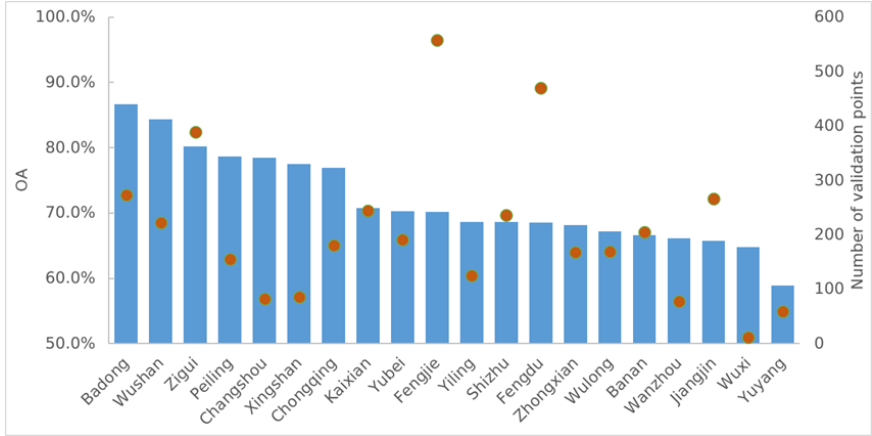
Figure 9. The OA of the trained proposed model in other counties based on field validation points. Solid points represent number of validation points. Blue bars represent the